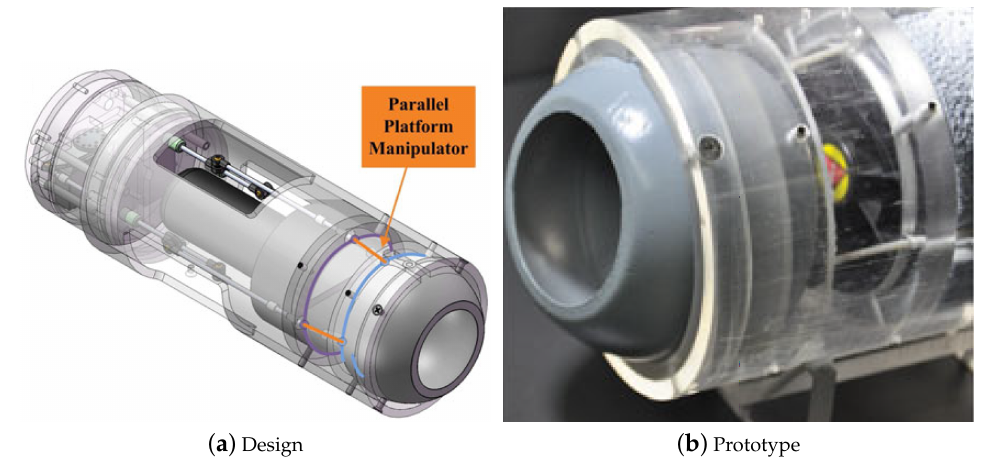
Figure 9. MASUV-1: A miniature AUV with RT [57]. In [58] (2013, see Figure 10), similarly to [53] (2009), a pumped-water-jet-based RT is presented, using three actuators to assure more 2-DOF of reconfiguration to the thrust. In the same year, two propositions were published showing the application of RTs in two different propulsion architectures (see Figure 11): the Smart-E AUV [59] and the so called Italian sea-stick [60] apud [61]. In these publications, RTs are called pivoted thrusters . The Smart-E AUV realizes a holonomic drive with only three thrusters. The Italian sea-Stick is a hybrid solution since it is also equipped with rudders.